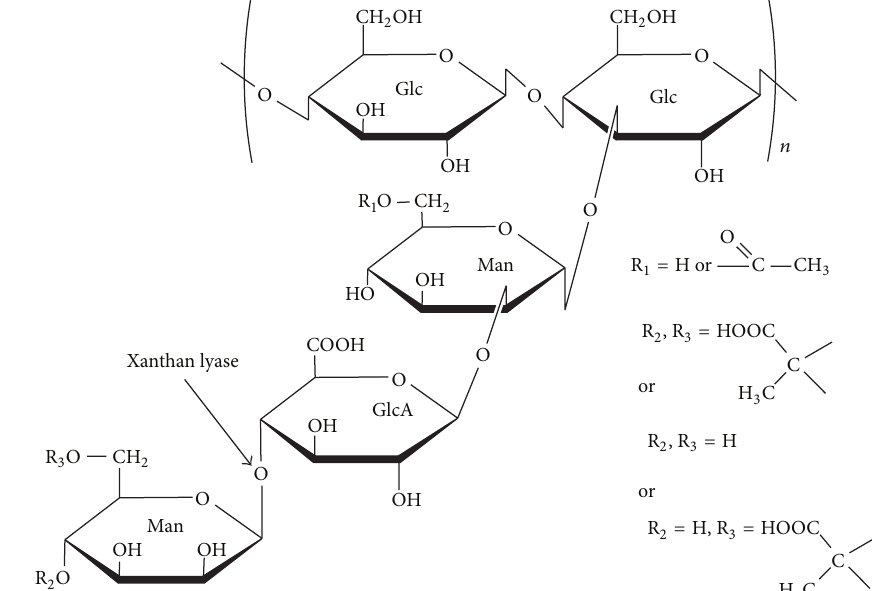
Figure 1: Chemical structure of xanthan. The cleavage site for xanthan lyase is indicated by solid arrows. Glc, D-glucose; Man, D-mannose; GlcA, D-glucuronic